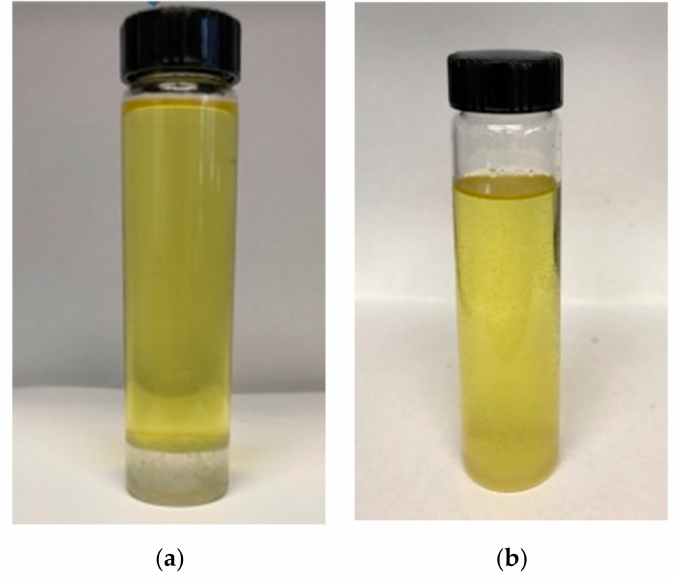
Figure 2. Stability test of emulsified B20 with 10% water with Atlox 4914 and mixture of Span 80 and Tween 80. ( a ) EB20W10% (Atlox 4914, layer separation); ( b ) EB20W10% (Span and Tween 80, no layer